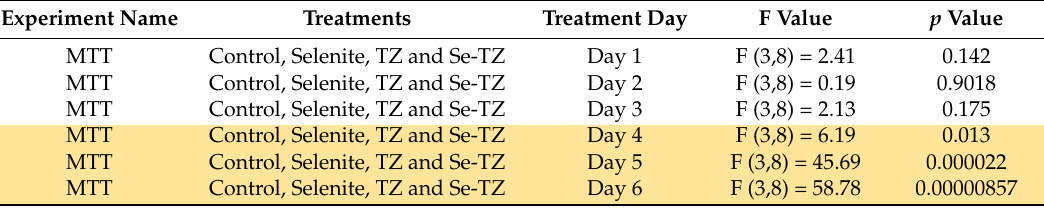
Table 3. ANOVA Results for Cell Metabolism with Se-TZ Treatment for MDA-MB-468 Cells.